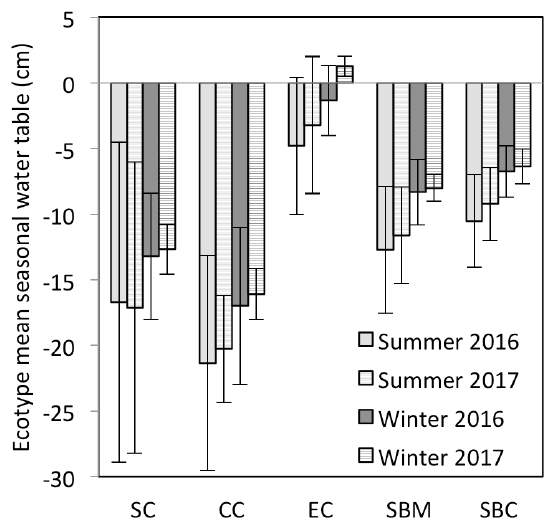
Figure 3. Mean seasonal water table for each of the ecotypes for summer (April–September) and winter (October–March), for which the mean annual water table is measured with respect to the spring- time peat surface or Sphagnum surface (if present). The ecotypes are abbreviated as SC for Sphagnum cutover, CC for Calluna cu- tover, EC for Eriophorum cutover, SBM for submarginal, and SBC for subcentral.